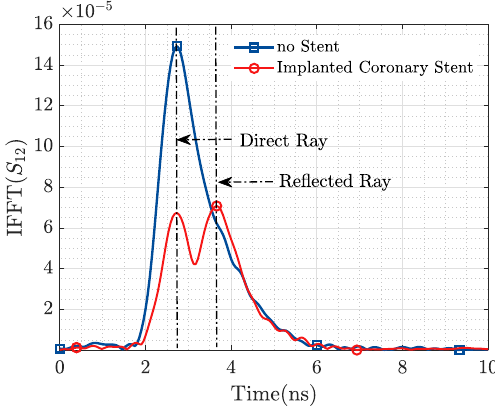
Figure 12. Coronary Stent Sensing.